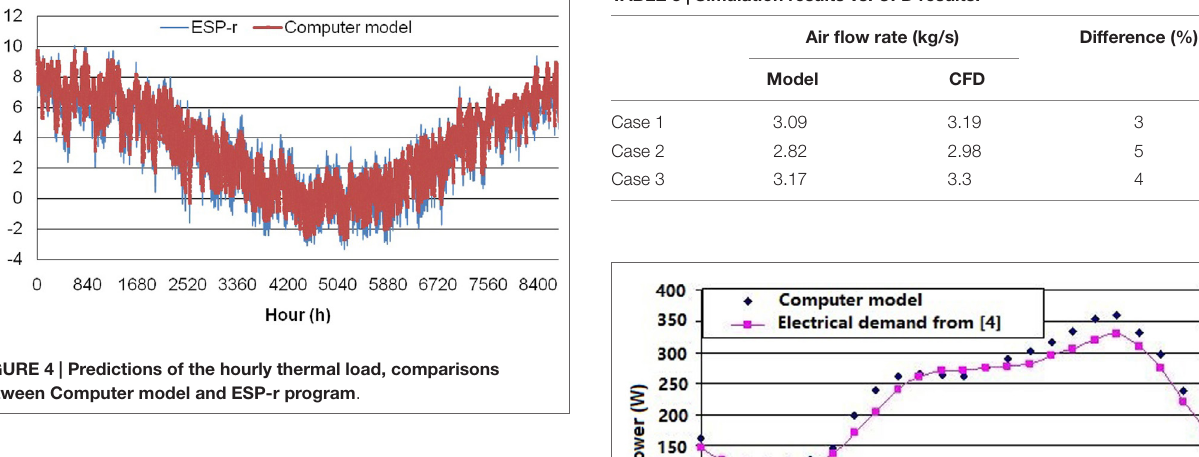
TaBle 2 | information for the cases tested in this study.